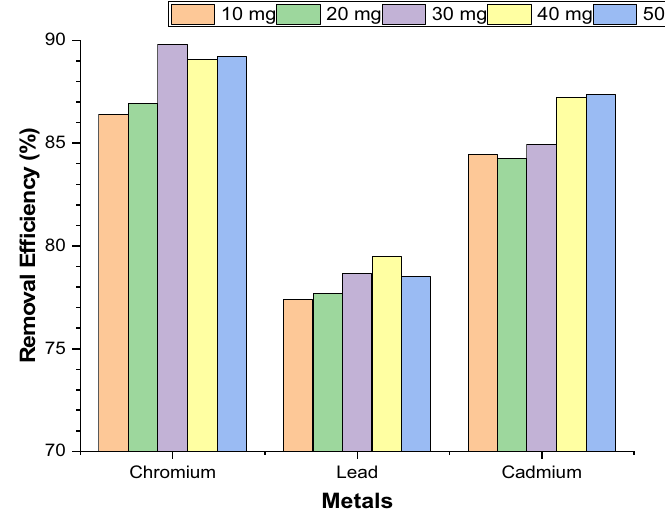
Figure 7. Effect of adsorbent dosage for removal of Cr(VI), Pb(II), and Cd(II).